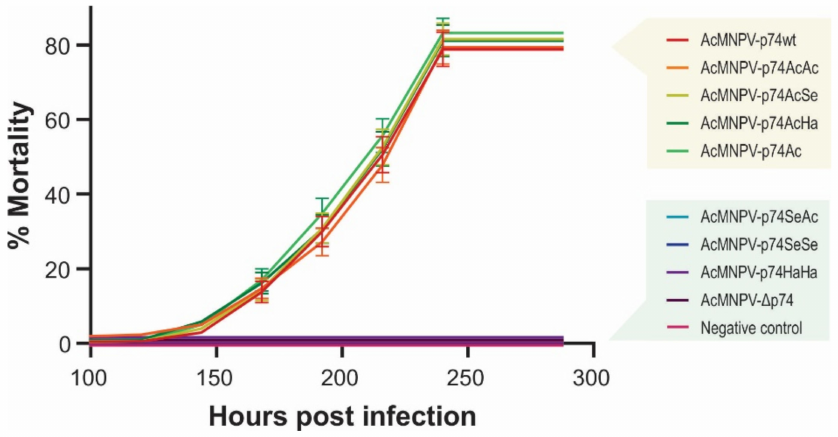
Figure 8. Virulence of the recombinant AcMNPVs in R. nu . Mortality percentages of third-instar larvae of R. nu orally infected by the droplet feeding method with the different variants of OBs (1 × 10 7 OBs/mL). Bioassay results (48 larvae in experimental units of 16 individuals for each treatment) are shown, and standard deviations are included. Exposed insects were maintained at 26 ◦ C, and mortality was recorded every 24